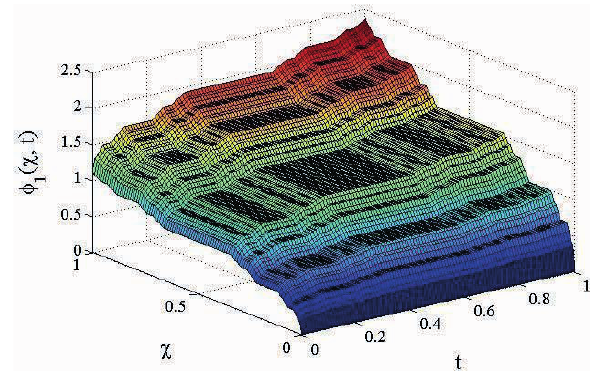
Fig. 1: Numerical simulation of first order approximation with non- differentiable terms when γ = ln2